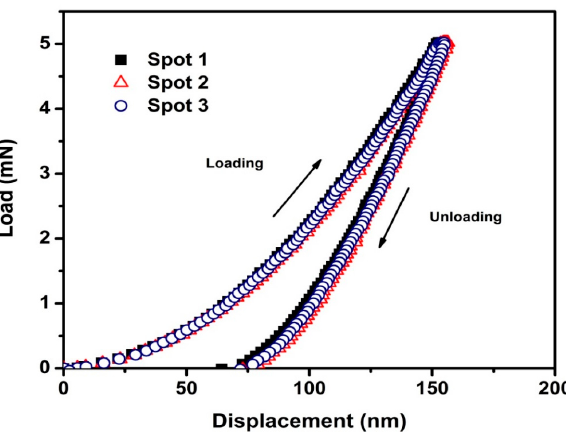
Figure 10. Nanohardness and elastic modulus values of Mo-DLC coatings with different Mo contents.